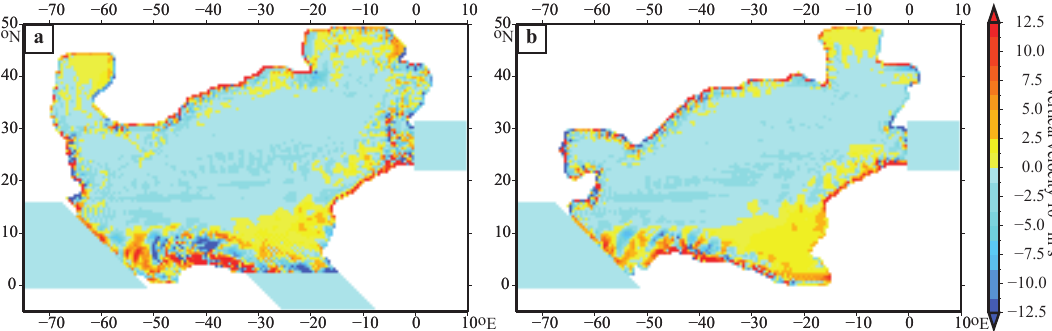
Fig. 9. Upwelling. Modelled vertical velocity at 40m depth for an experiment with (a) an open connection with the South Atlantic through the EAS (SATL), and (b) a reduced shelf area due to low sea level (LOWSL-TET).